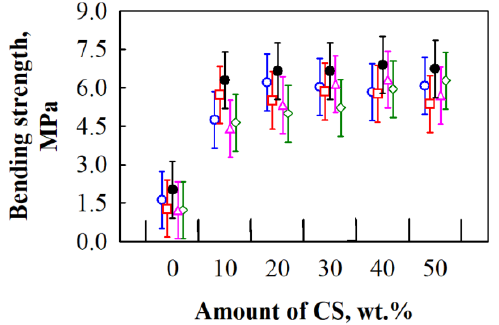
Figure 7. Impact of various amounts of CS binder and different HS fractions on bending strength of BcB: ○ — 5/10 mm; □— 10/20 mm; ◊— 2.5/20 mm; ∆— 2.5/5 mm; ●— shredded HS.